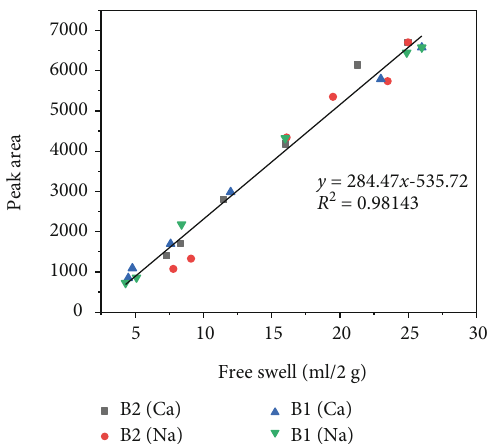
Figure 9: Linear fi tting relationship between total peak area and FSI.